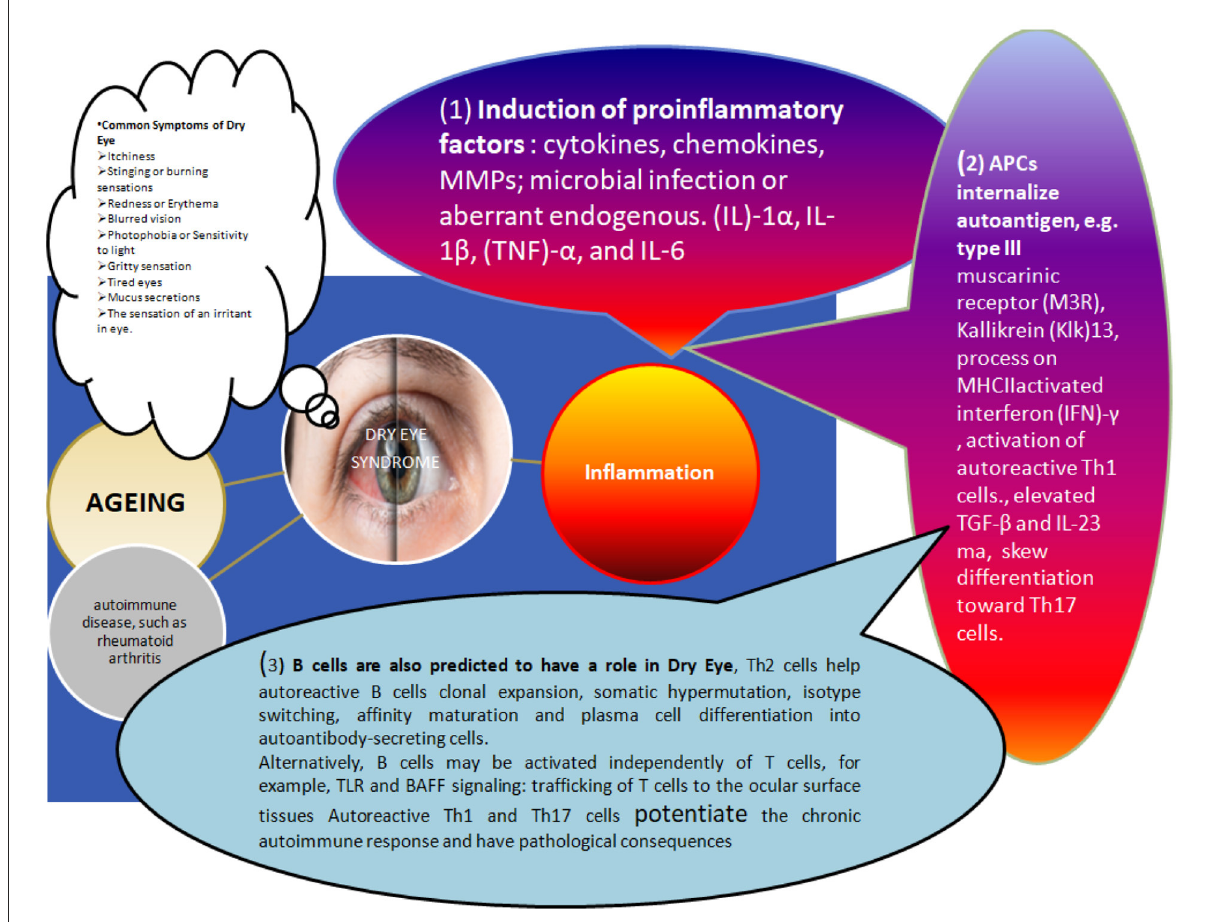
FIGURE2 Different factors causing dry eye associated changes in the human ocular surface and disease manifestations: The immunopathogenesis of Dry Eye disease involves many causing agents, including age-related changes, Hormonal imbalance, and infections. Still, most of these agents predominantly display their impact through violation of the ocular surface’s delicate immune-regulatory mechanism. The inflammatory response caused by various factors triggering these immune changes can be described as (1) Initiation of Induction of proinflammatory factors: as shown in the figure, cytokines, chemokines, and matrix metalloproteinases (these initial signals can trigger MMPs). This might involve microbial infection-induced downstream signaling [e.g., Toll-like receptor (TLR) signaling]. Various acute inflammatory cytokines (e.g., IL-1 α , IL-1, tumor necrosis factor TNF- α , IL-6, etc.) are reported in higher concentrations in dry eye conditions and can amplify inflammatory reactions through APCs activation. In addition, APCs secreted IL-12 and INF- γ eventually activates the differentiation of autoreactive T-cells (e.g., Th1 cells). (2) Secondly, A DIFFERENT COMBINATION OF CYTOKINE AND THEIR ELEVATED CONC (e.g., IL-6, TGF- β , IL-23) can skew toward Th17 cells. Thirdly, B cells also contribute to all these inflammatory changes Related to dry eyes. For example, autoreactive B cells are triggered by